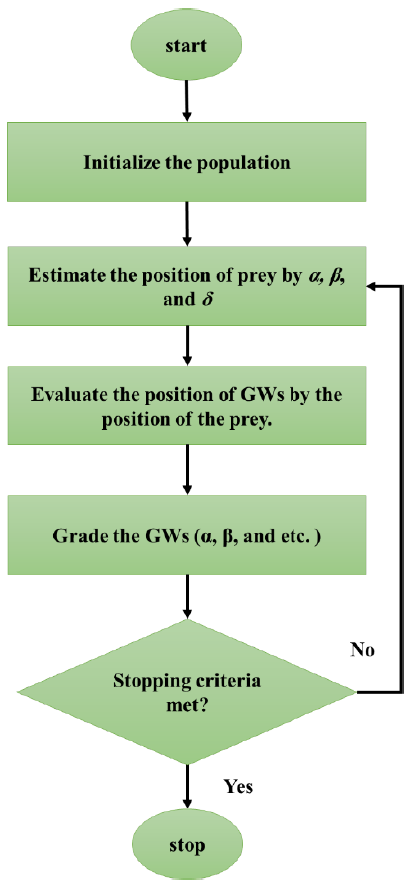
Figure 7. The flowchart of the grey wolf optimization (GWO) algorithm